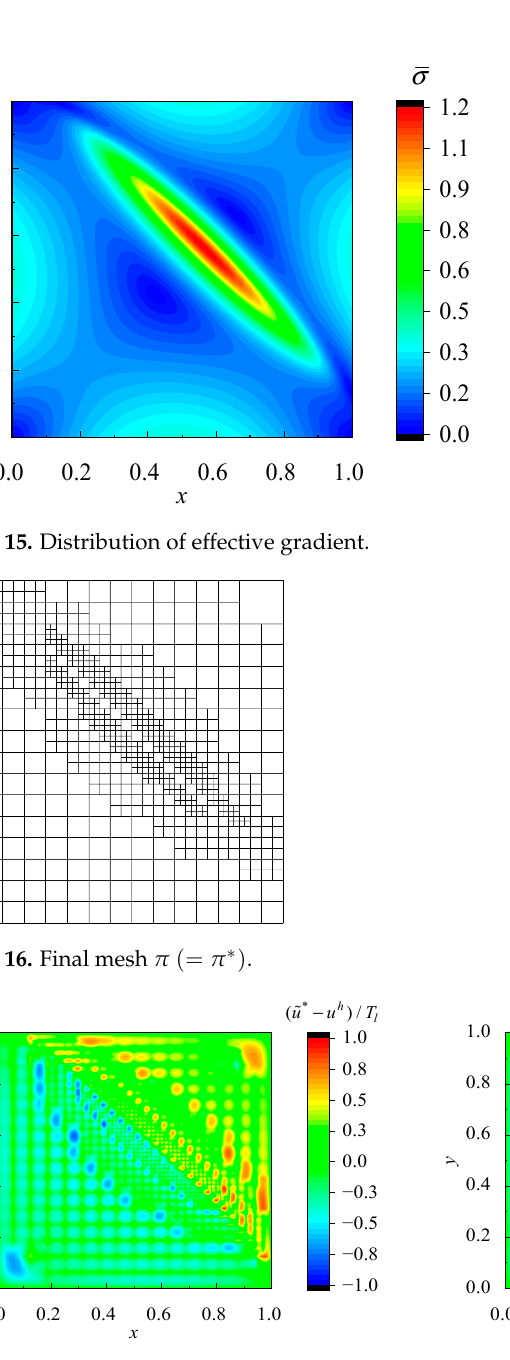
criterion set in Equation (18).